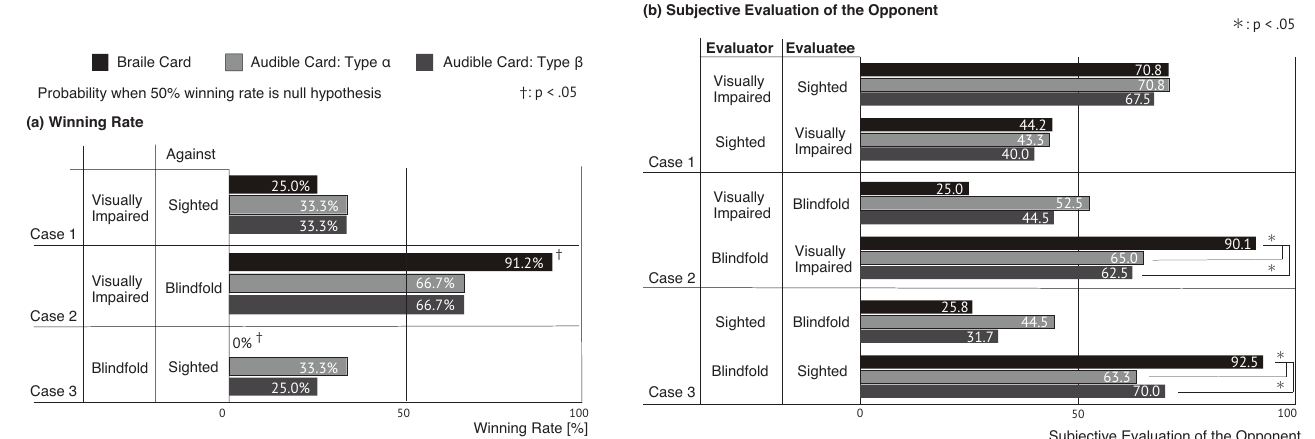
Figure 4. ( a ) Winning rate of the people with visual impairments in Cases 1 and 2 and those with a blindfold in Case 3, ( b ) subjective evaluation of the opponent: The opponent’s strength [0, 100] when the player strength is